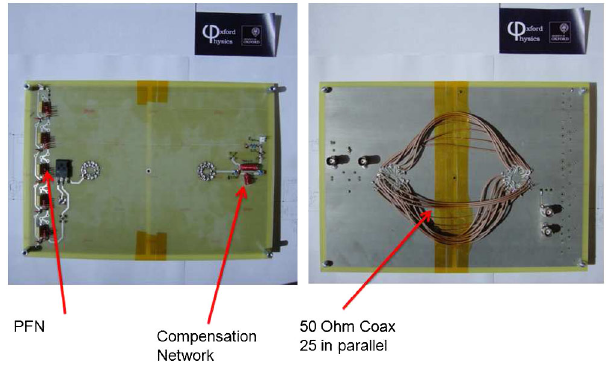
FIG. 40. PFN test circuit, courtesy of Johan Fopma (Oxford).